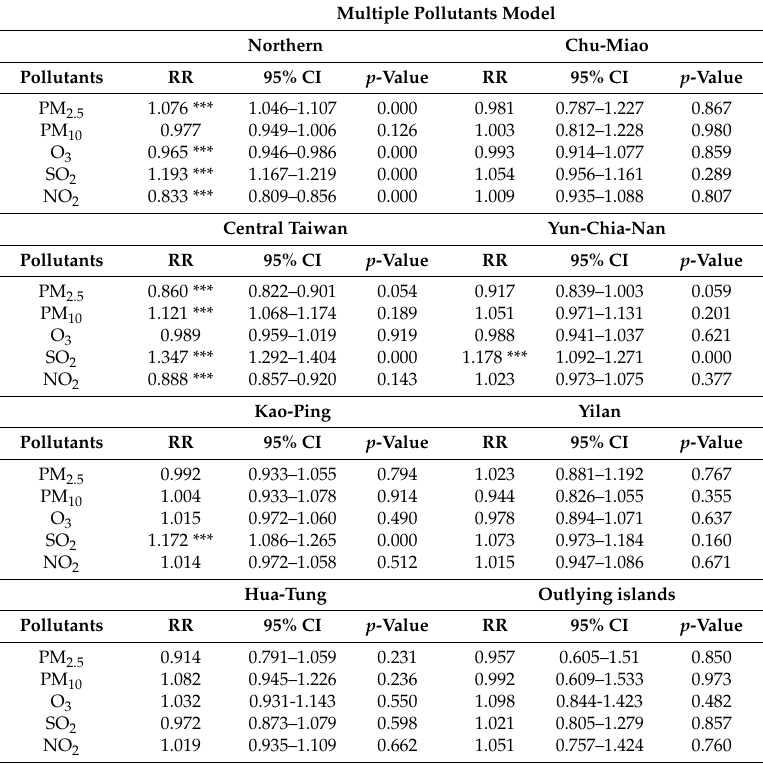
Table 6. Relative risks of asthma hospitalization associated with air pollutants in different regions—a multiple pollutants